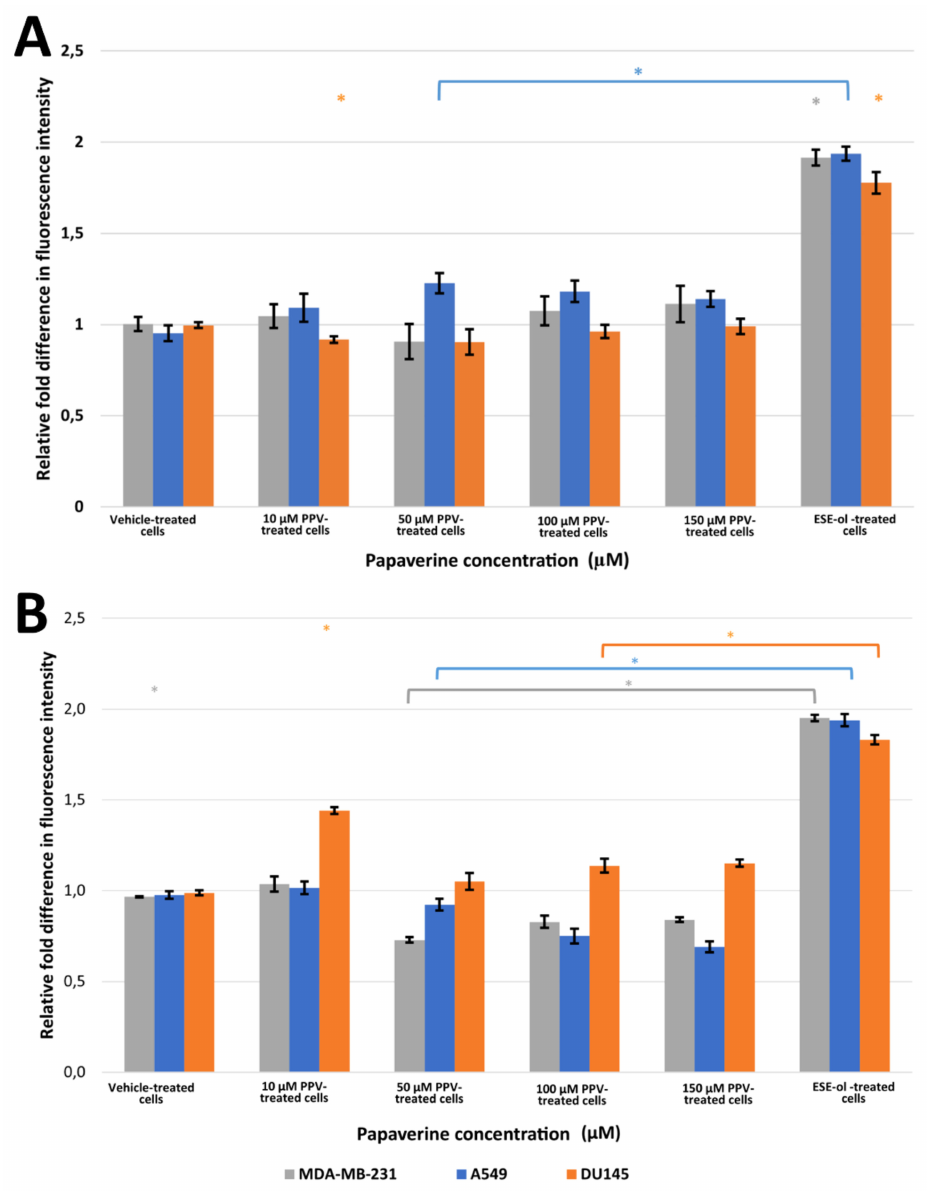
Figure 5. Fluorescence microscopy results of DCFDA staining demonstrating the effects of PPV (10–150 µ M) on H 2 O 2 production on MDA-MB-231, A549, and DU145 cell lines at 48 h ( A ) and 72 h ( B ). The average of three independent experiments is represented by the graph with error bars indicating standard deviation. Statistical significance is represented by an * when using the Student t-test with a p value of 0.05 compared to cells propagated in growth